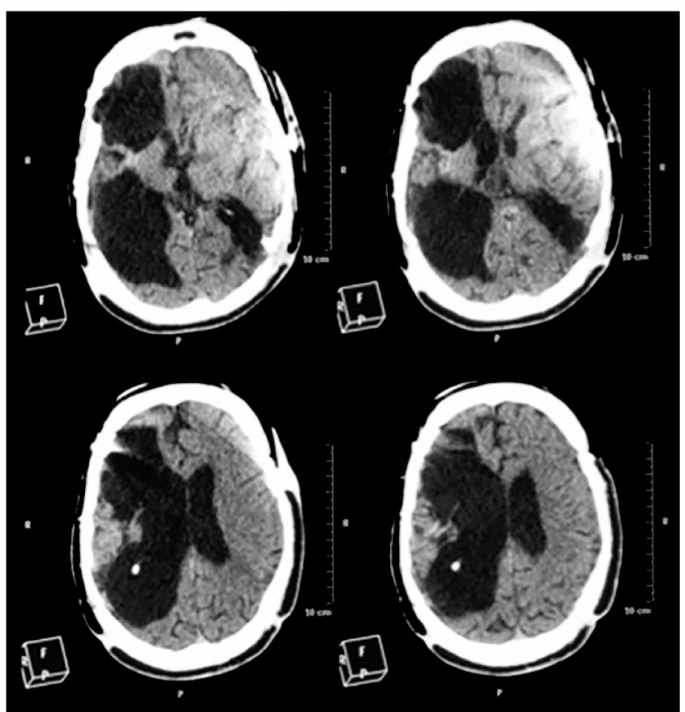
Figure 6. Two years of treatment. Despite the clinical improvements, a new CT-Scan revealed that the brain injury was higher than that observed in the first days after the accident and in the CT-Scan carried out two months later. Injuries in the right hemisphere were increased and new injuries appeared on the left one. Scale bar: 12 cm. F: Front. R: Right: P: